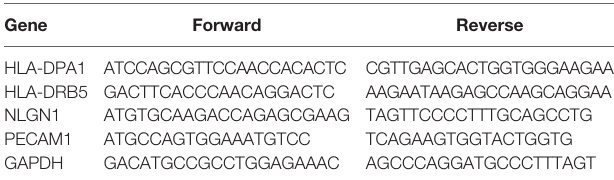
TABLE 2 | List of primer sequences of related